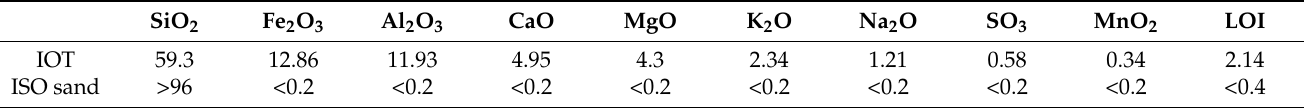
Table 4. Physical parameters of IOT and ISO sand.